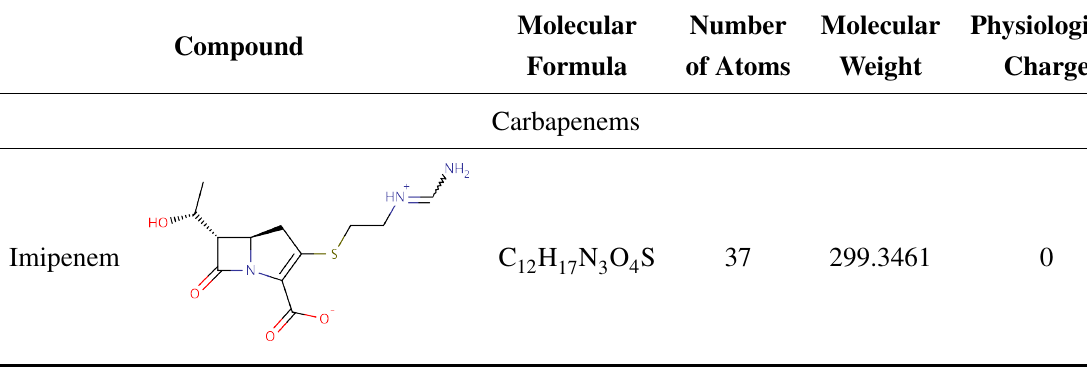
Table A1. List of antimicrobial compounds included in the current version of the